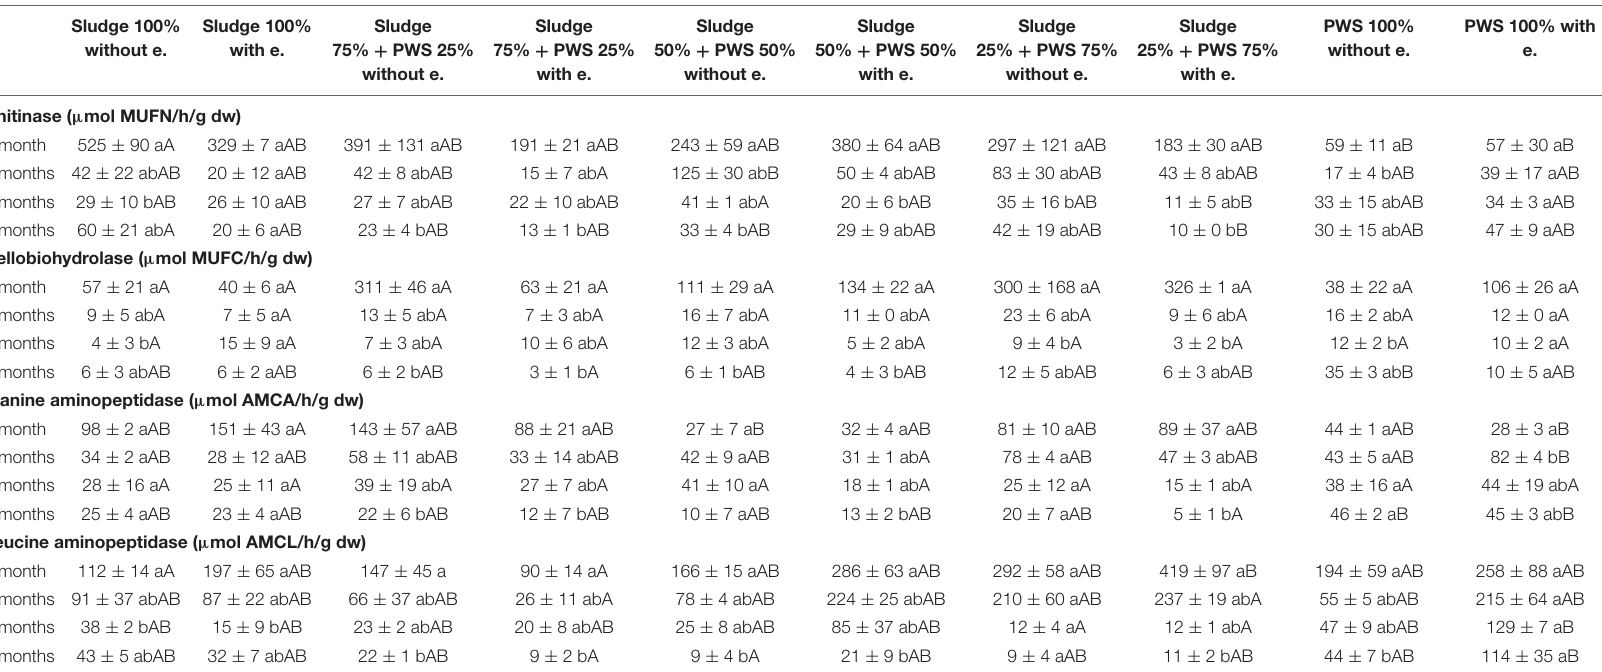
4 months 43 ± 5 abAB 32 ± 7 abAB 22 ± 1 bAB 9 ± 2 bA 9 ± 4 bA 21 ± 9 bAB 9 ± 4 aAB 11 ± 2 bAB 44 ± 7 bAB 114 ± 35 aB Values are means ± SD (n = 3). Different lowercase letters in a column indicate significant differences between months, while capital letters indicate significant differences among treatments (Kruskal–Wallis test, P ≤ 0.05). dw, dry weight; PWS, pelletized wheat straw; e. = earthworms; MUFN, 4-methylumbellyferyl-N-acetylglucosaminide; MUFC, 4-methylumbellyferyl-N-cellobiopyranoside; AMCA, L-alanine-7-amido-4-methylcoumarin; AMCL,